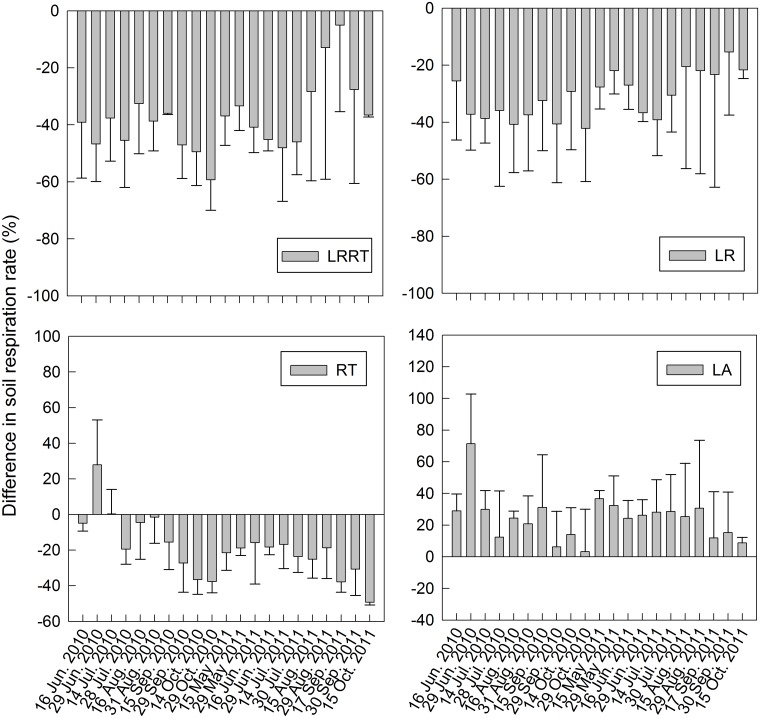
Changes in soil respiration rates in the various organic matter treatments as a function of time. Bars represent standard errors.